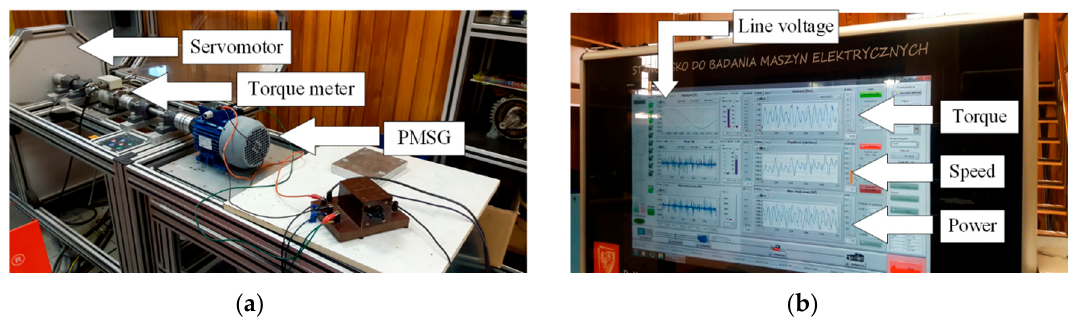
Figure 7. Laboratory: ( a ) test bench and ( b ) measurement’s display interface.